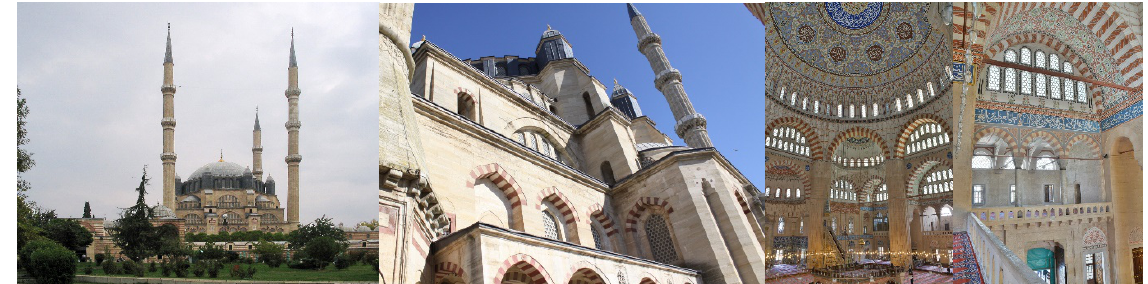
Figure 1. The mosque of Edirne, Turkey – exterior view (left), detail view (centre) and interior view